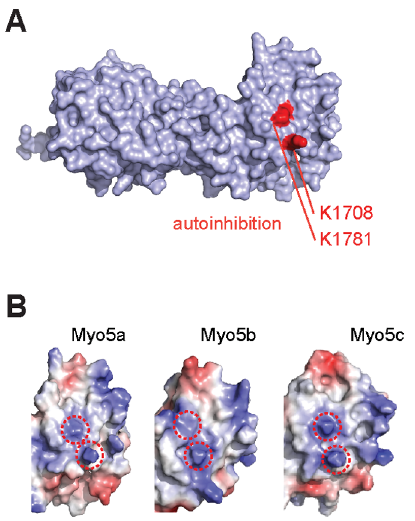
Figure 3. C-terminal globular domains of all three human type V myosins potentially mediate autoinhibition. ( A ) Surface representation of Myo5a GD with residues K1708 and K1781 highlighted in red. Their mutation resulted in a loss of autoinhibition [23]. ( B ) Comparison of electrostatic surface potentials of K1708 and K1781 (red circles) with identical positions in Myo5b and Myo5c and the conservation of these residues in all three paralogs (Figure S3 in File S1) suggests that autoinhibition might be a general feature of human type V myosins. Figures were generated with the program Pymol.